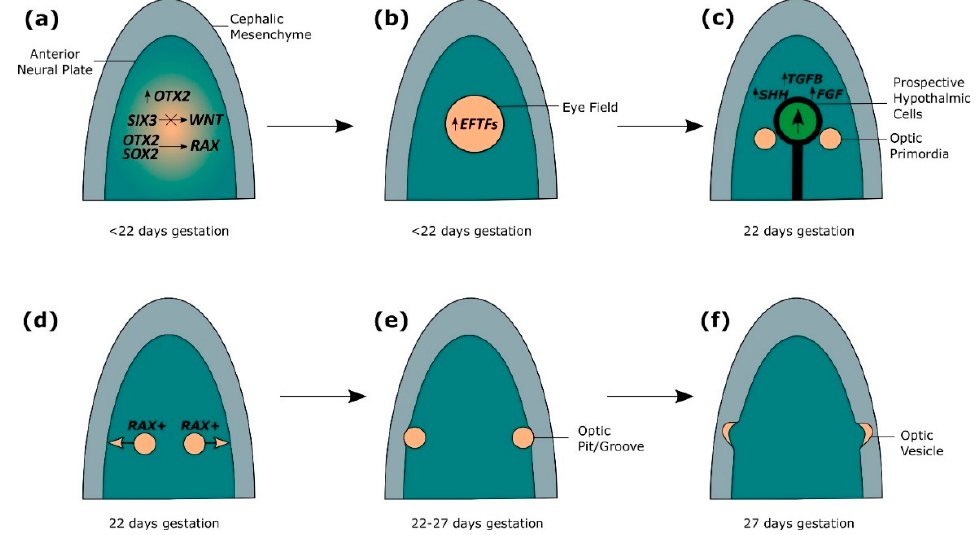
Figure 2. The genetics of early optic vesicle development. ( a ) A single eye field is induced at the midline of the anterior neural plate, through OTX2 and SOX2 coregulation of RAX , along with SIX3 -mediated repression of WNT , which allows upregulation of eye field transcription factors (EFTFs) including PAX6 , RAX , LHX2 , TBX3 and SIX6 . ( b ) The eye field is formed expressing EFTFs, which form a self-regulating network su ffi cient to coordinate the development of the eye through suppression of genes that antagonize eye development and upregulation of genes required for eye development. ( c ) Secretion of factors from TGF β , FGF and SHH families from the underlying axial mesoderm stimulate the anterior migration of prospective hypothalamic cells, causing the eye field to split in two to form bilateral optic primordia. ( d ) Cellular proliferation and bilateral migration of the optic primordia is regulated by RAX . ( e ) The optic primordia evaginate from the forebrain through the cephalic mesenchyme forming bilateral optic pits / grooves. ( f ) Extended evagination of the optic pits through the cephalic mesenchyme results in the formation of bilateral optic